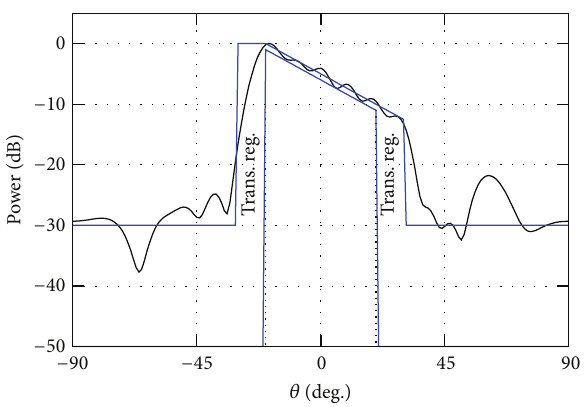
Figure 19: Beam pattern of a 𝑁 = 15 element linear array, shaped to 𝑆 𝑟𝑥 (0 ∘ ,𝜃) using the real encoded GA of